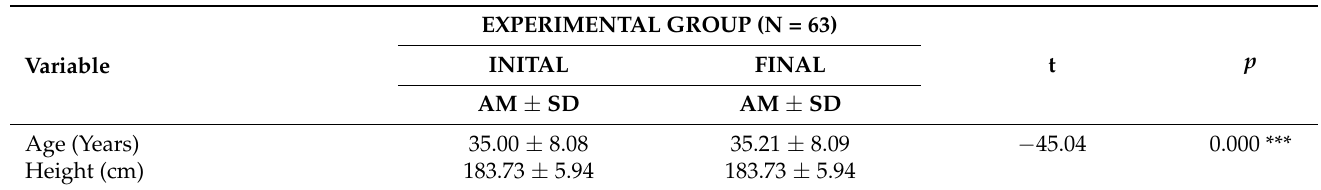
Table 4. Statistical significance of differences in arithmetic means ( t -test) of chronological age and anthropometric characteristics of the initial and final tests of the experimental